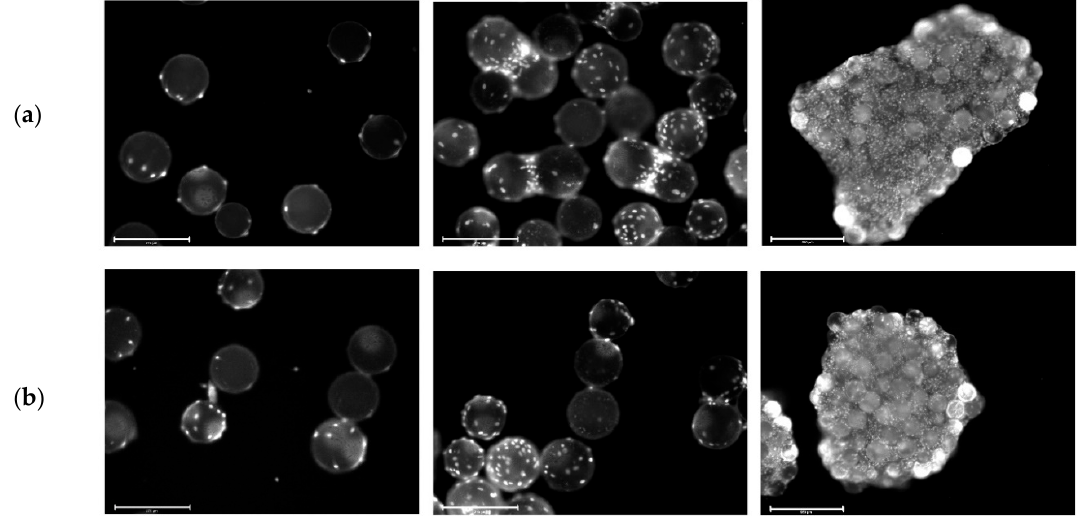
Figure 5. Fluorescence microscopic images during cell growth in Corning spinner flasks. Donors 080 ( a ) and 085 ( b ). DAPI-stained cells on Microcarriers (MCs) on day 1 (left), day 4 (middle) and day 9 (right). Scale bars: 275 µm (left and middle) and 650 µm (right).